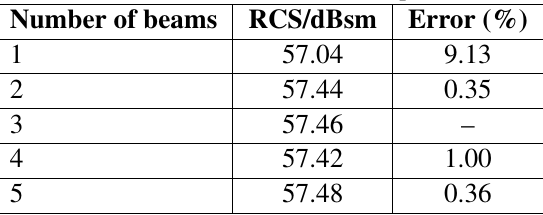
Table 3 The RCS error of Ship